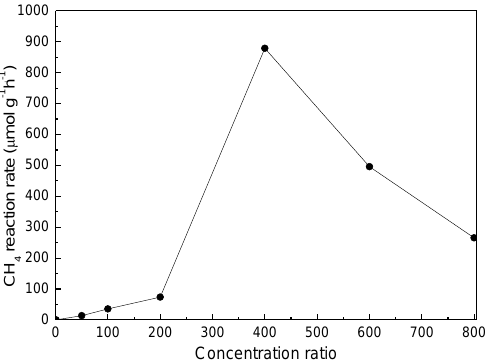
Figure 9. CH 4 yields and rate under simulated concentrating lights: ( left ) yield, ( right ) reaction rate.